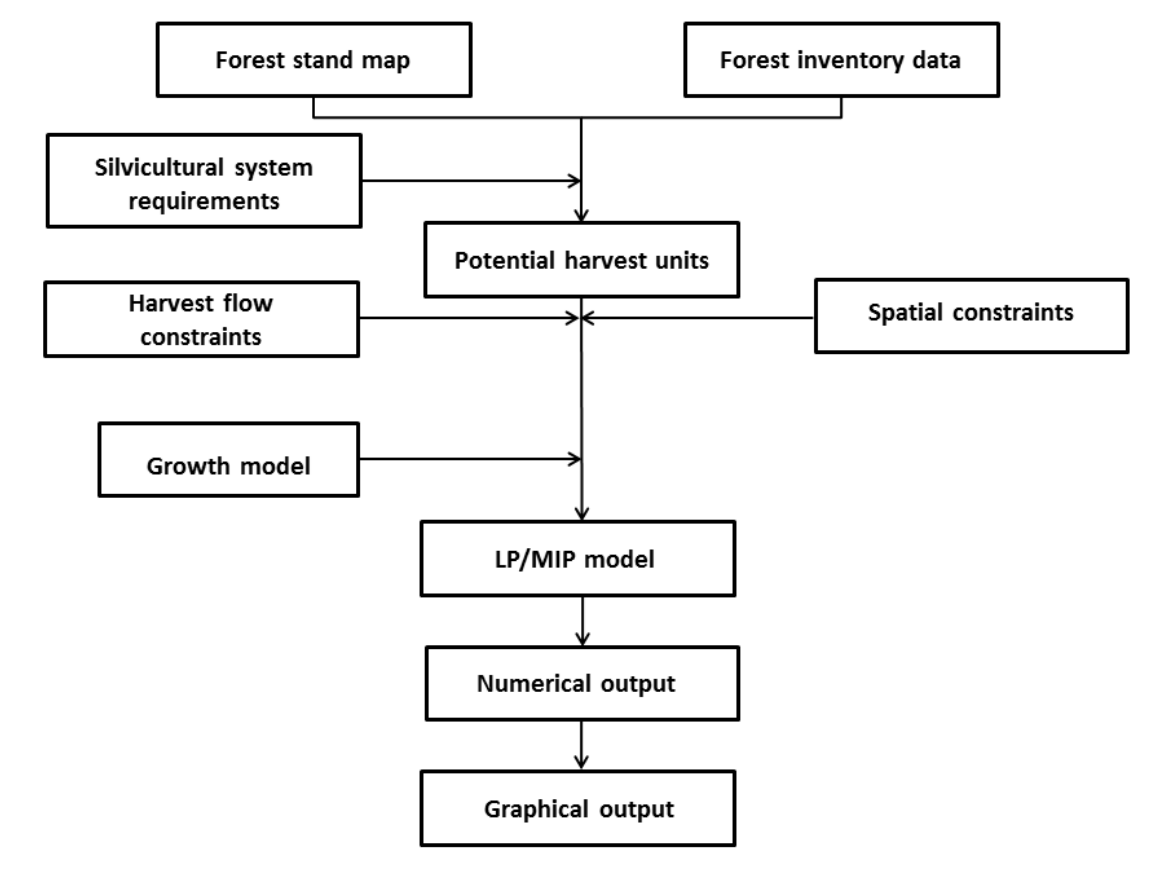
Figure 1. The logical structure of Optimal.